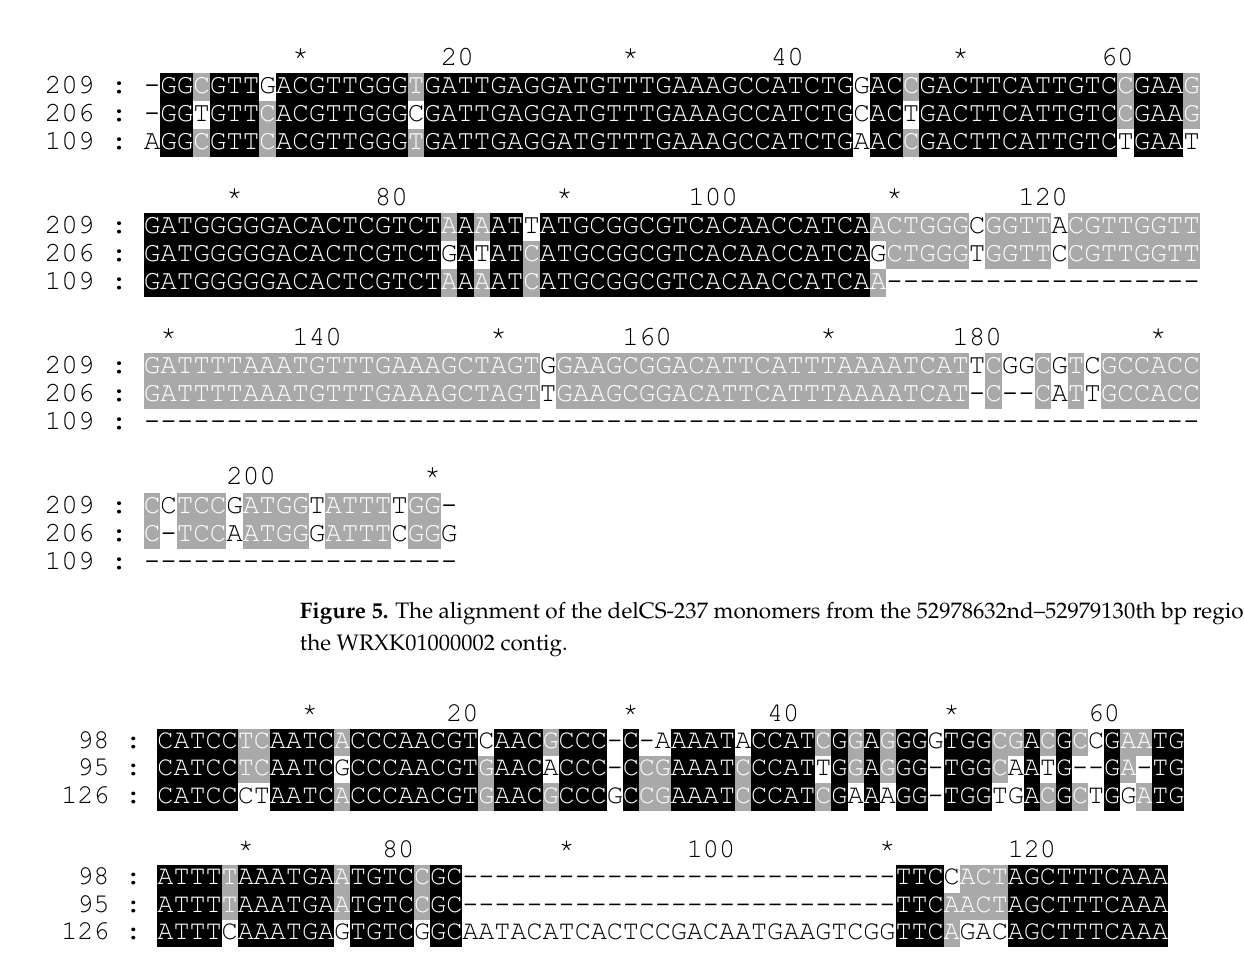
Figure 6. The alignment of short subunits of the delCS ‐ 237 monomers and 126 bp subunit of the CS ‐ 237 monomer.